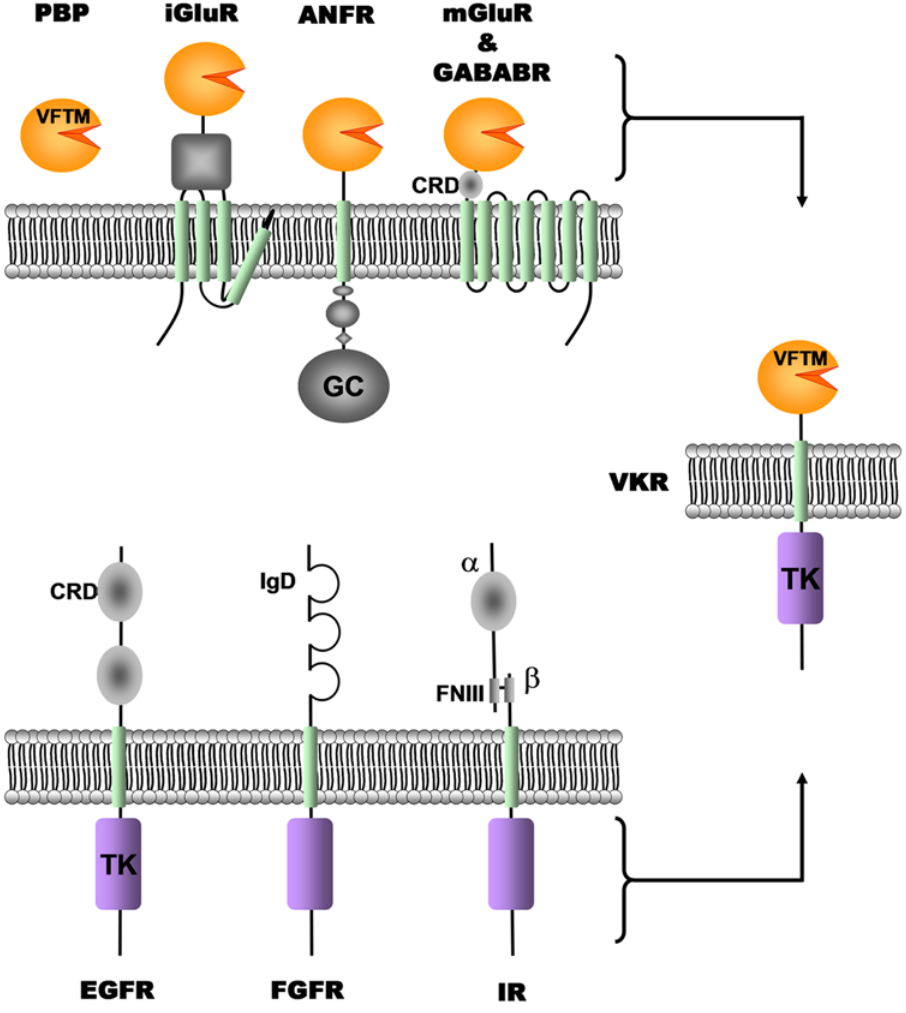
Figure 1. VKR are original proteins composed of a VFTM associated to a TK domain. The top panel represents the VFTM found in the bacterian periplasmic binding proteins (PBP) and in eukaryotic cell surface membrane receptors (iGluR: ionotropic Glutamate Receptor; ANFR: Atrial Natriuretic Factor Receptor; mGluR: metabotropic Glutamate Receptor; GABA B R: metabotropic a -aminobutyric acid Receptor). The bottom panel represents various RTK (EGFR: Epidermal Growth Factor Receptor; FGFR: Fibroblast Growth Factor Receptor; IR: Insulin Receptor composed of a and b chains). VFTM: Venus Flytrap Module, GC, Guanylate Cyclase domain; TK, Tyrosine Kinase domain; CRD: Cystein Rich Domain; IgD: Immunoglobulin Domain; FNIII: FibroNectin III